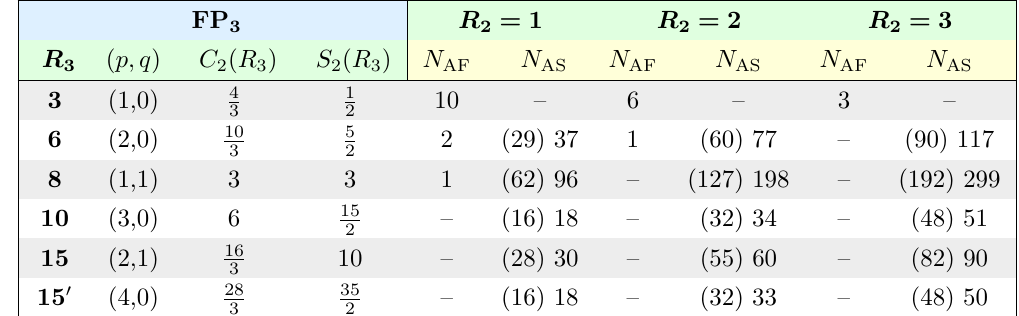
Table 4 . Asymptotic freedom versus asymptotic safety at the partially interacting (cid:12)xed point FP 3 : shown are the maximal numbers of BSM fermion (cid:13)avors compatible with asymptotic freedom, N AF , and the smallest number of (cid:13)avors required for an asymptotically safe (cid:12)xed point FP 3 to exist, N AS , both in dependence on the fermion representations R 2 and R 3 under SU(2) L and SU(3) C , respectively. N AS values in brackets relate to the absolute lower bound, those without to (cid:12)xed points with 0 < (cid:11) (cid:3) ; (cid:11) (cid:3) < 1. Also indicated are the weights ( p; q ), quadratic Casimir, and Dynkin y 3 index under